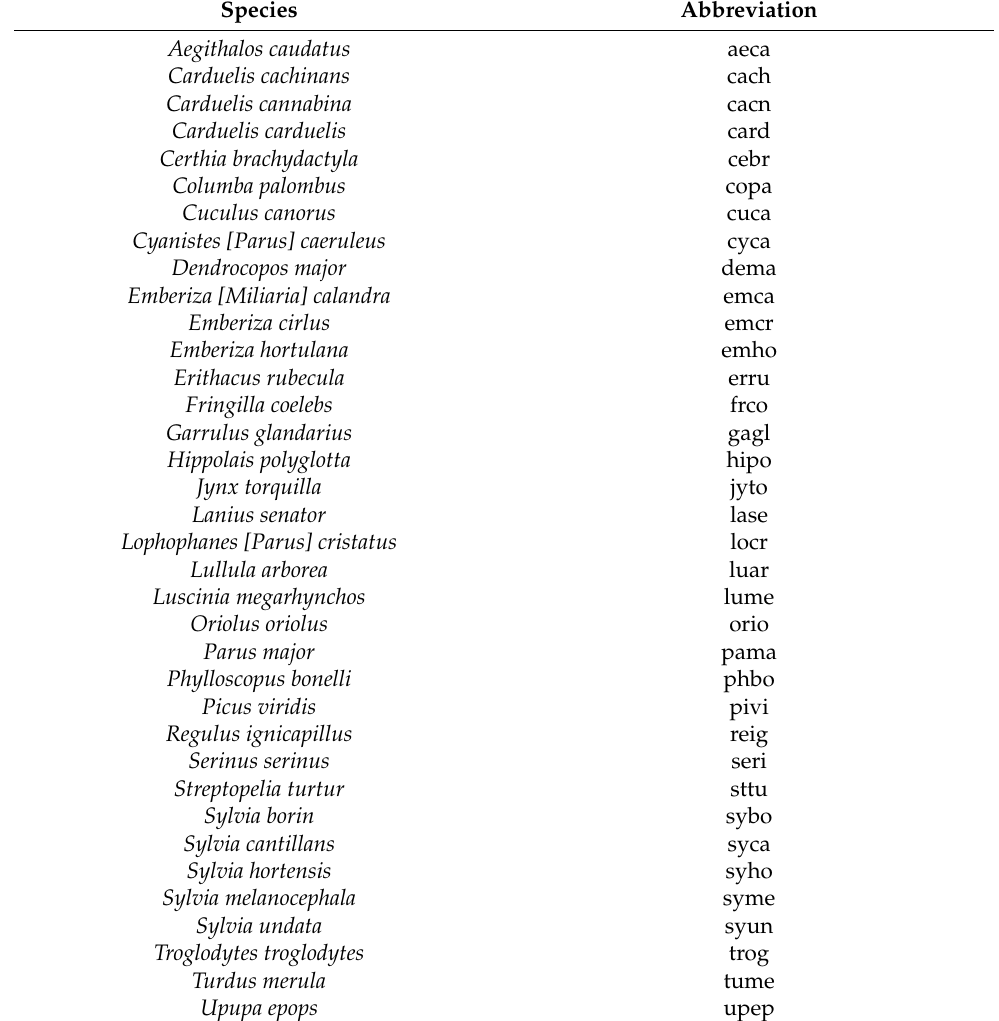
Table A1. List of the recorded species taken into account in the calculations, with